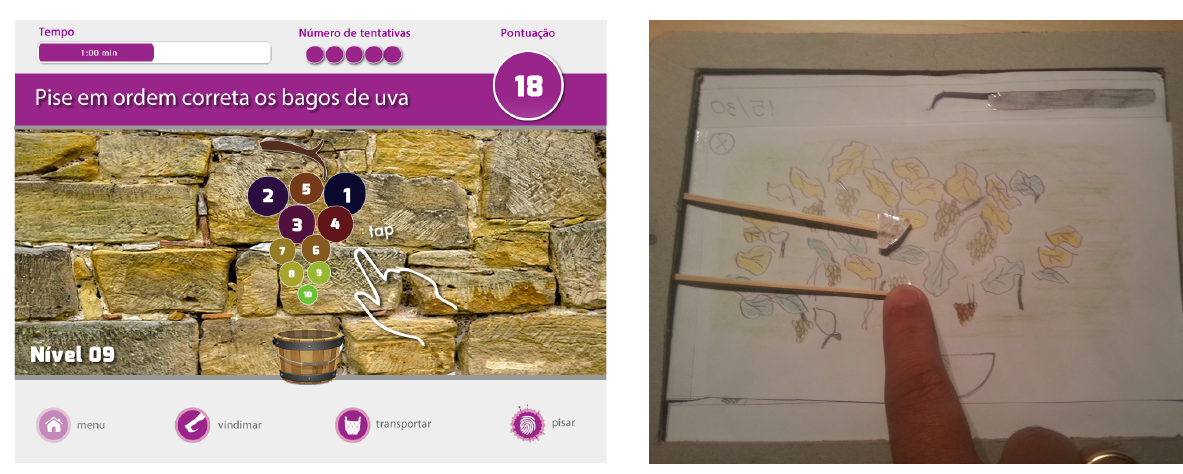
Fig. 4. Game activity proposal for mental exercise of elderly users Fig. 5. Paper prototype model with